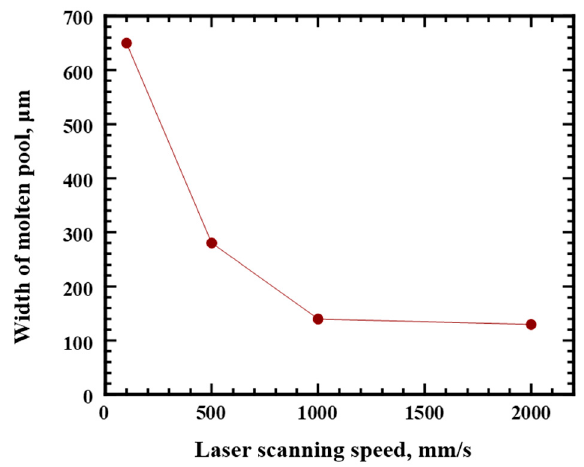
Figure 6. Variation in the width of the molten pool upon laser irradiation of the Ni-9 at.% Al-16 at.% V alloy specimen as a function of the laser scan speed.